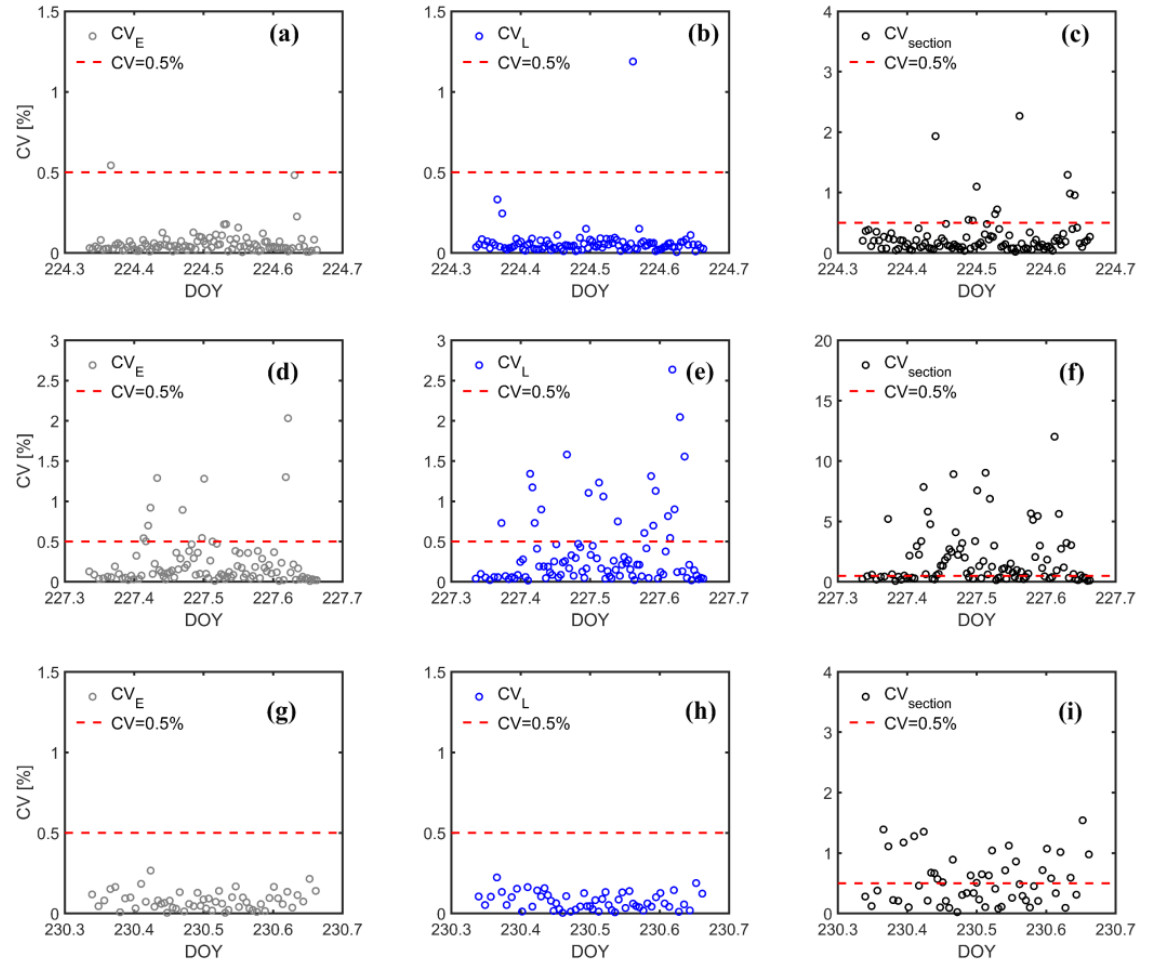
Figure 5. The diurnal dynamics of CV E , CV L , and CV section under three sky condition days: ( a – c ) for the clear day (DOY 224); ( d – f ) for the rapidly fluctuating illumination condition day (DOY 227); and ( g – i ) for the cloudy day (DOY 230). The gray dots represent the CV s of downwelling irradiance measurements. The blue dots represent the CV s of upwelling radiance measurements. The black dots represent the CV s of the measurement sections.